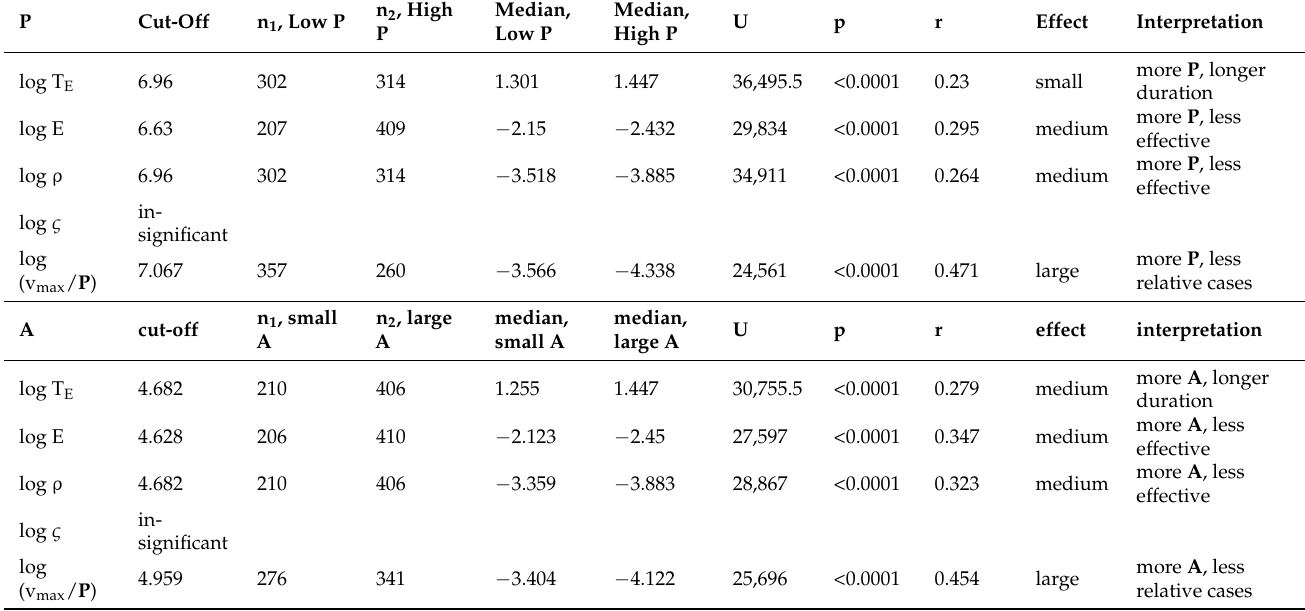
Table 4. Relationship between epidemiological parameters and geographical and